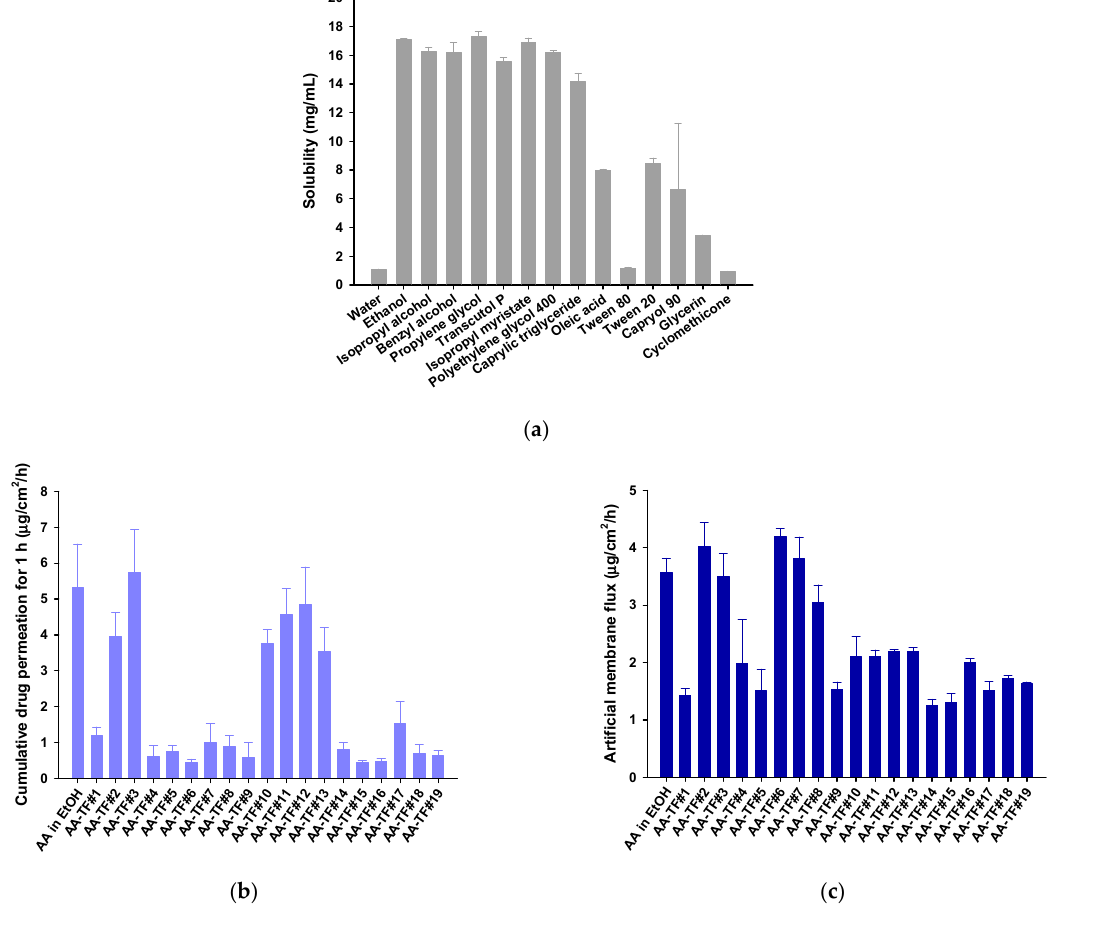
Figure 1. ( a ) Solubility of atraric acid (AA) in various solvents and surfactants. In vitro infiltration of AA using topical formulations (AA–TFs) into an artificial membrane; ( b ) Cumulative drug permeation for the initial first hour; and ( c ) Flux of AA in ethanol or AA–TFs. Values are presented as mean ± SDs ( n = 4 for each group).